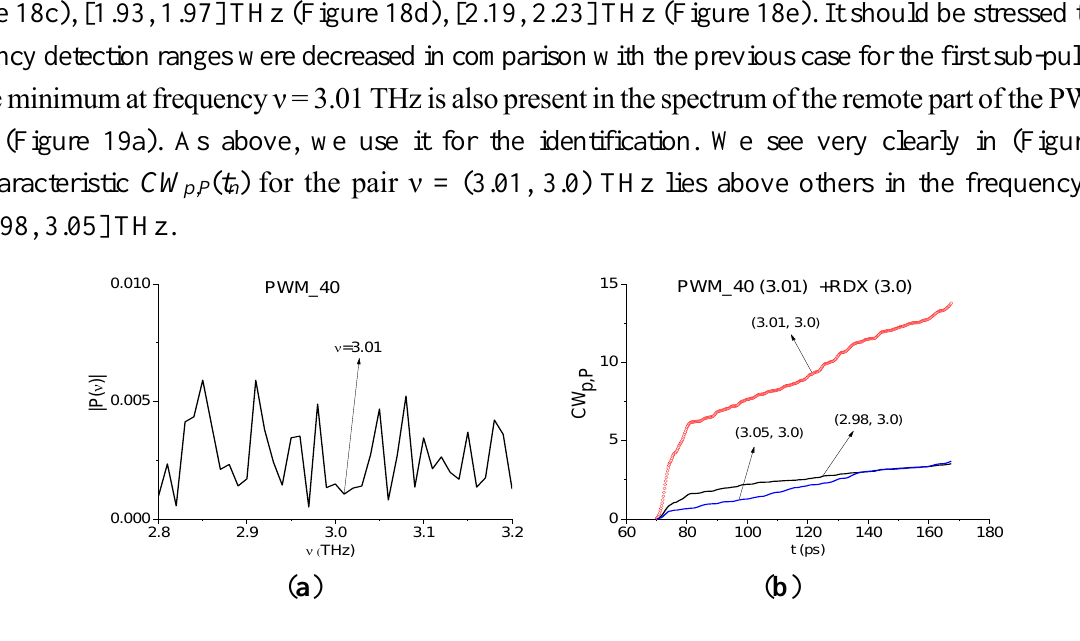
Figure 19. Fourier spectrum of the PWM_40 signal calculated in the time interval t = [70, 170] ps ( a ); integral characteristics CW p , P ( t n ) detecting the frequency ν = 3.01 THz ( b